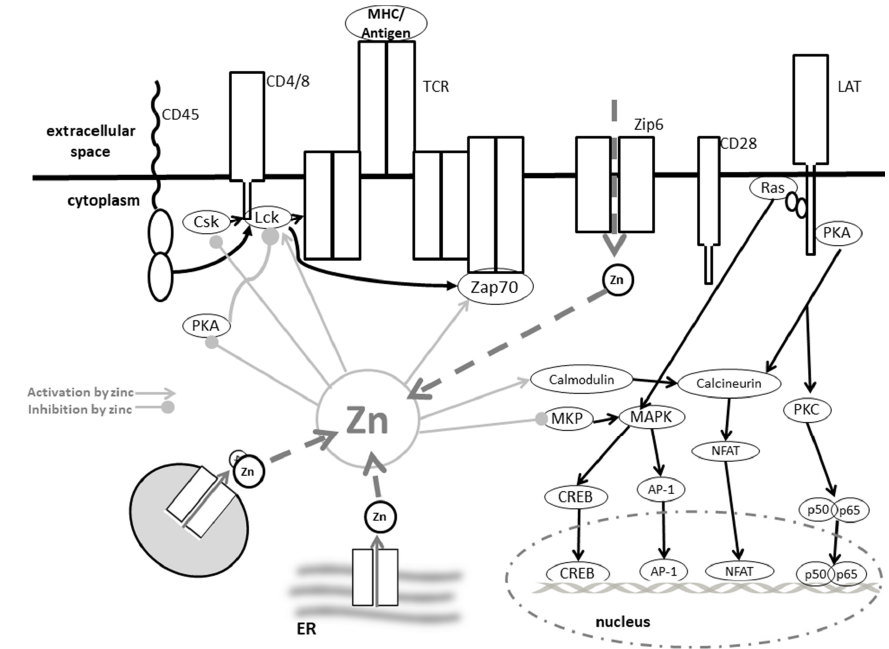
Figure 3. Zinc in TCR ‐ induced signaling. For explanation, see text. Abbreviations: AP ‐ 1: Activator protein 1; CREB: cAMP response element ‐ binding protein; Csk: C ‐ terminal Src kinase; ER: endoplasmic reticulum; Lck: lymphocyte ‐ specific protein tyrosine kinase; LAT: linker for activation of T cells; MAPK: mitogen activated protein kinases; MHC: major histocompatibility complex; MKP: MAP kinase phosphatase; NFAT: Nuclear factor of activated T cells; p50/p56: nuclear factor NF ‐ kappa ‐ B subunit p50/p65; PKA: protein kinase A; PKC: protein kinase C; Ras: Rat sarcoma; TCR: T cell receptor; ZAP: z ‐ chain ‐ associated protein kinase; Zip: Zrt ‐ like, Irt ‐ like proteins. Modified after [109,170].